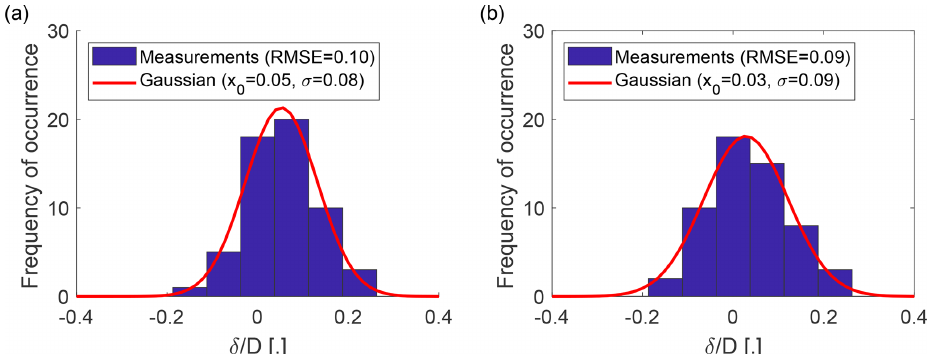
Figure 8. Histograms of the normalized wake deflection δ/D at x/D = 4 for the control cases with a successful wake-centre detection. Panel (a) shows the normalized wake deflection based on the yaw angle from the WindIris ( γ WI ) and (b) for the yaw angle of the WindCube ( γ WC ). Both 2D and 3D scans of wake-scanning lidar for control cases with a successfully detected wake centre are